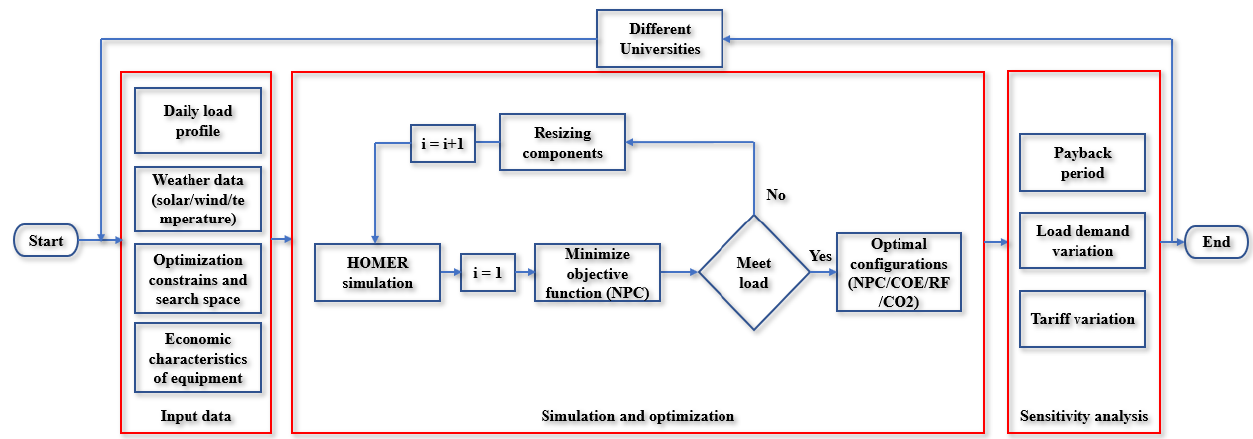
Figure 11: A flowchart of the optimization technique using HOMER